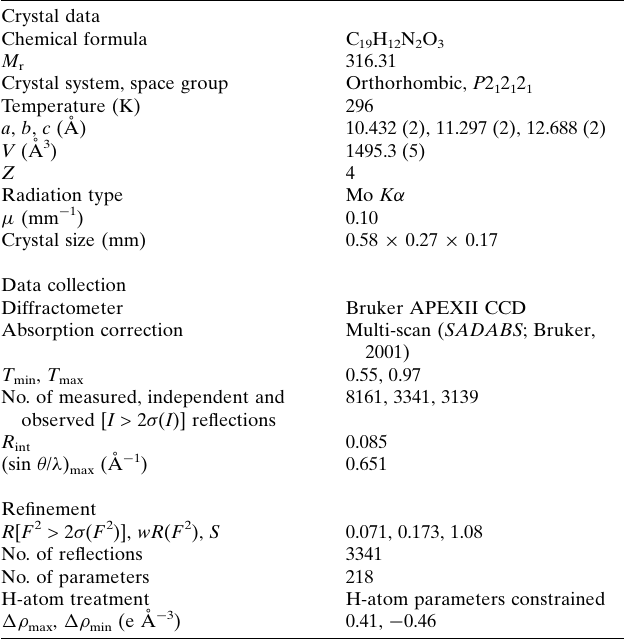
Table 2 Experimental